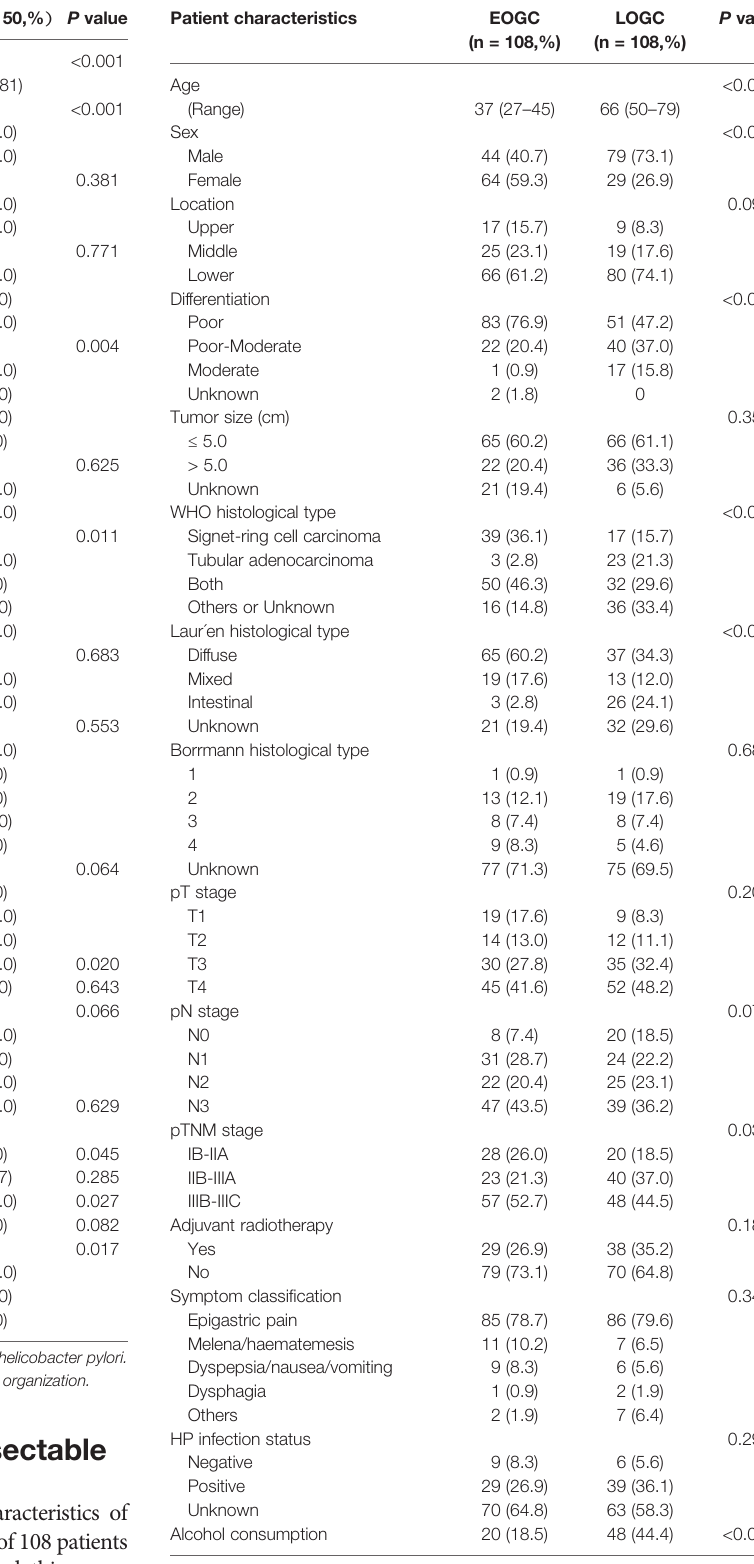
TABLE 1 | Patient characteristics with unresectable gastric cancer. TABLE 2 | Patient characteristics with resected gastric